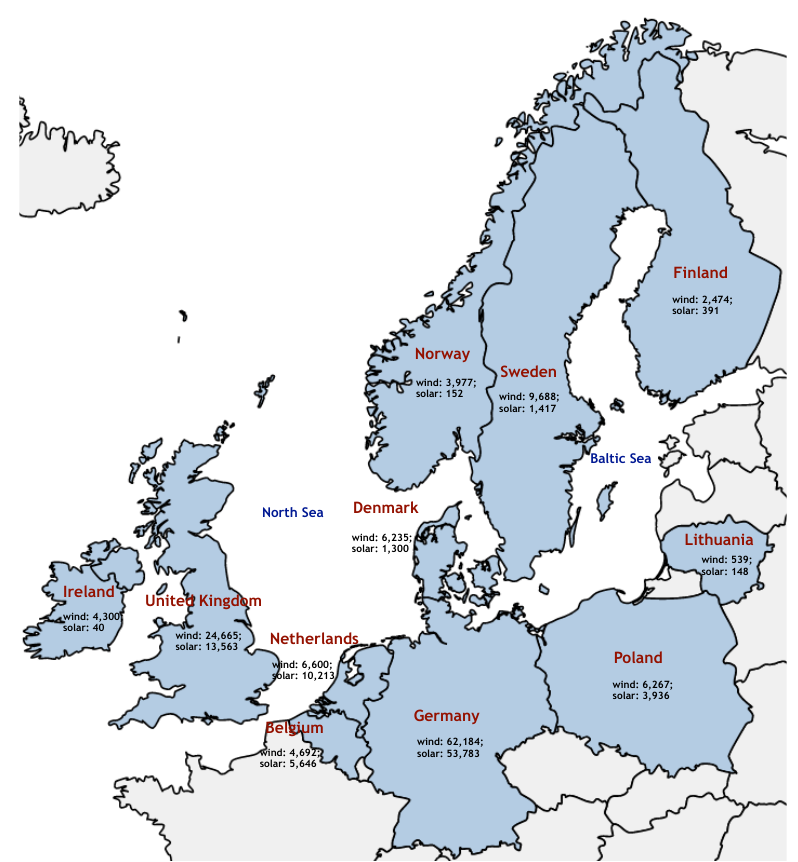
Figure 1. The eleven countries studied in the research bordering the North and Baltic Sea areas. For each country, the wind and solar capacities (MW) for the year of 2020 are listed, respectively [52]. The Renewables.ninja tool [48,49] is used to provide hourly wind and solar capacity factors (CF) aggregated nationally for 32 years (1985–2016). The hourly wind and solar capacity factors are based on the meteorological data from the MERRA-2 reanalysis